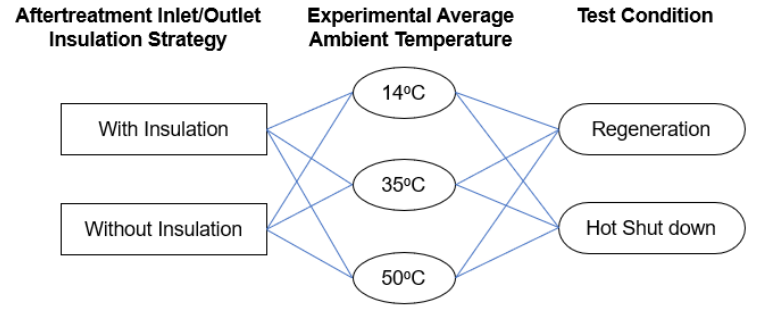
Figure 13. Experimental conditions design.